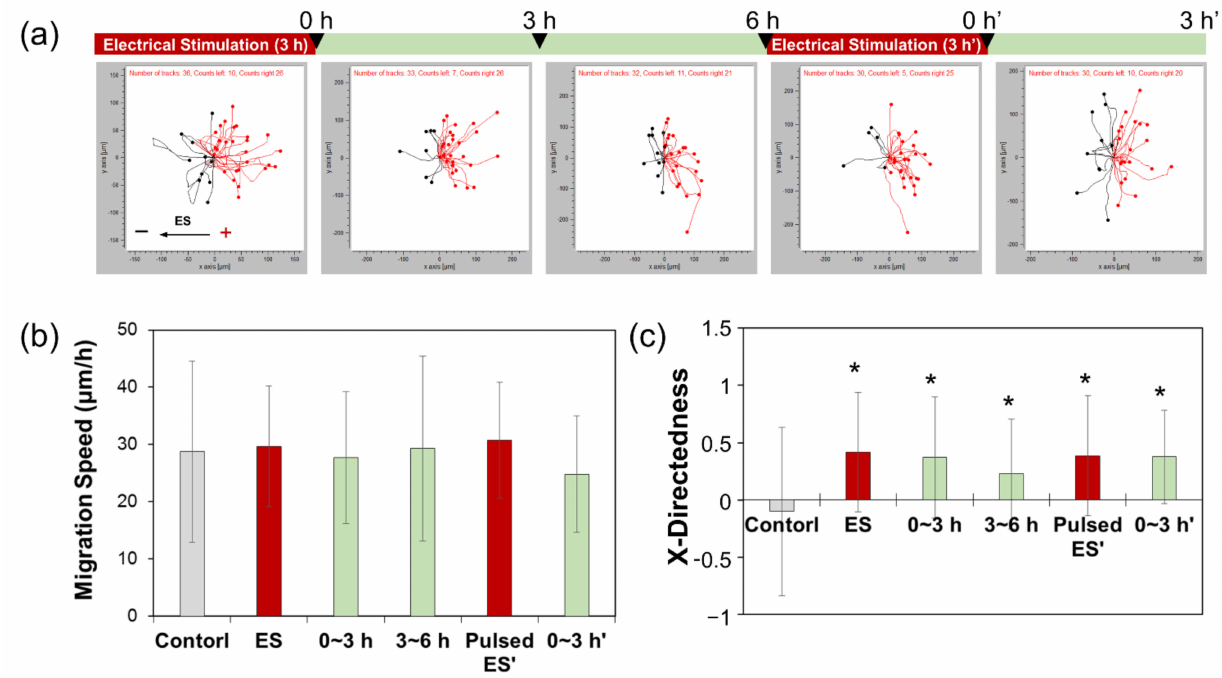
Figure 4. Migration assay of ADSCs subjected to 1200 µ A double-round pulsed electrical stimulation for 3 h, at a 6 h interval. ( a ) Cell tracking data, ( b ) migration speed, and ( c ) X-directedness were determined for ADSCs subjected to 1200 µ A electrical stimulation for 3 h, followed by 6 h rest and re-stimulation for 3 h. * represents p < 0.05 compared to controls not exposed to electric